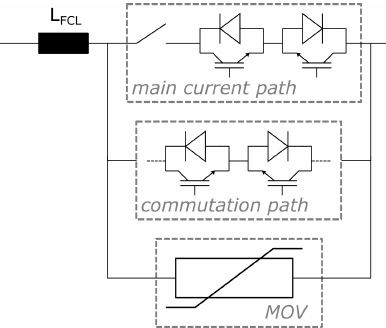
Figure 11. Generic hybrid DC circuit-breaker selection.